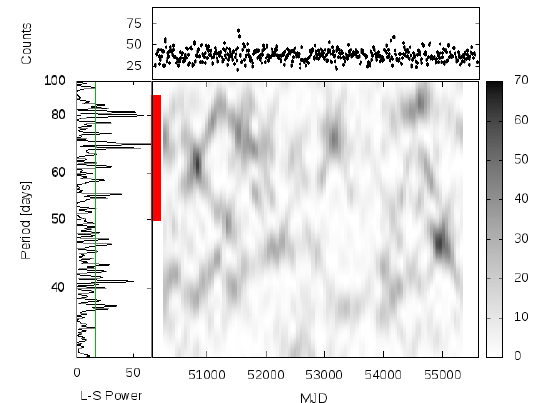
Figure 5: Cyg X-2: The unstable/chaotic behaviour may be associated with chaotic warping.